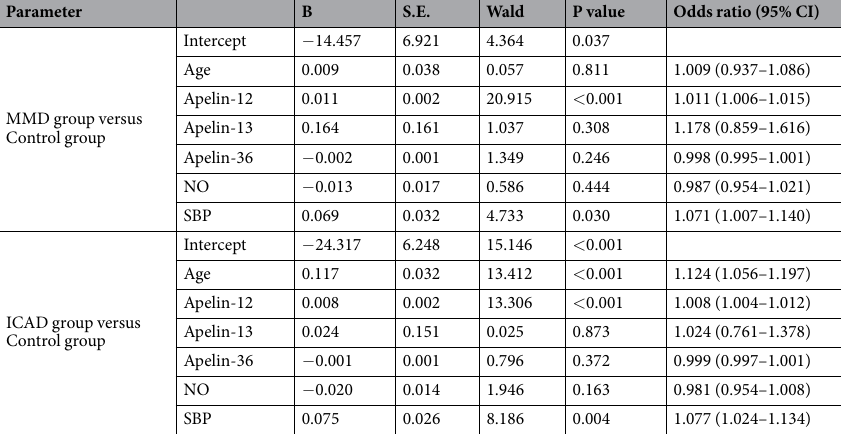
Parameter B S.E.